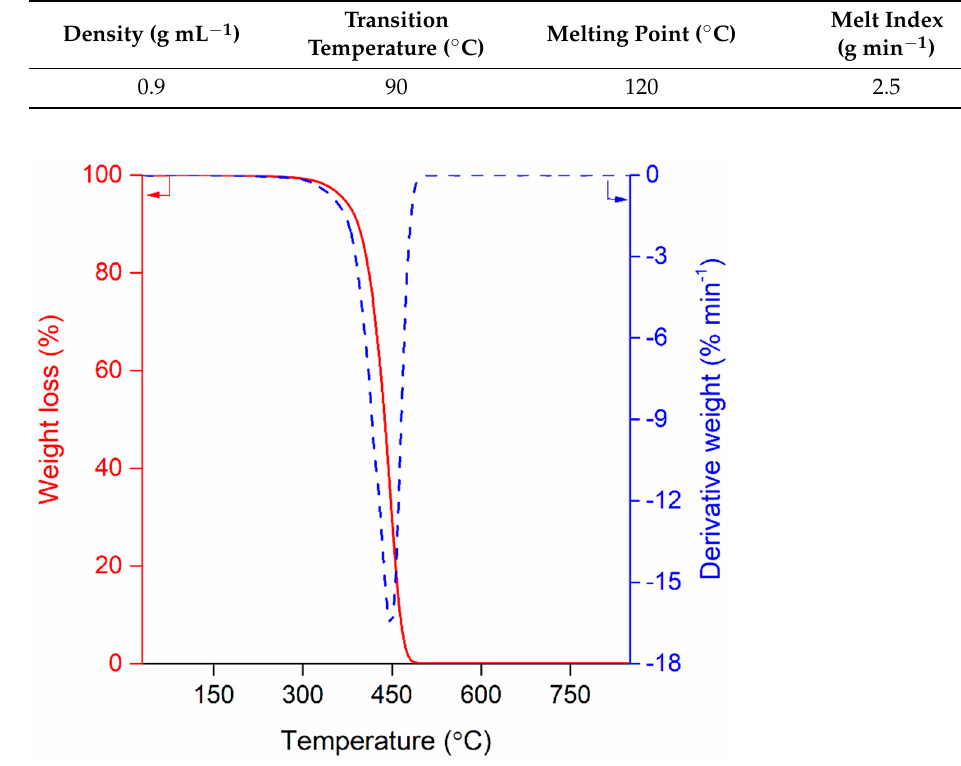
Table 1. Properties of the LDPE sample used as the feedstock in this study.